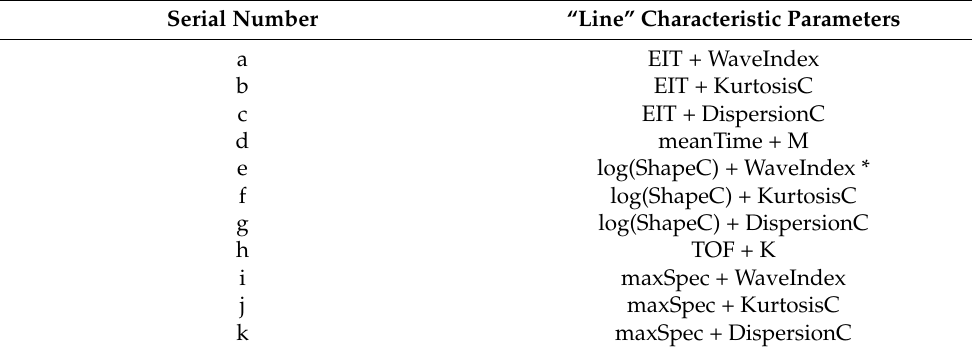
Table 5. “Line” characteristic parameters used to characterize battery